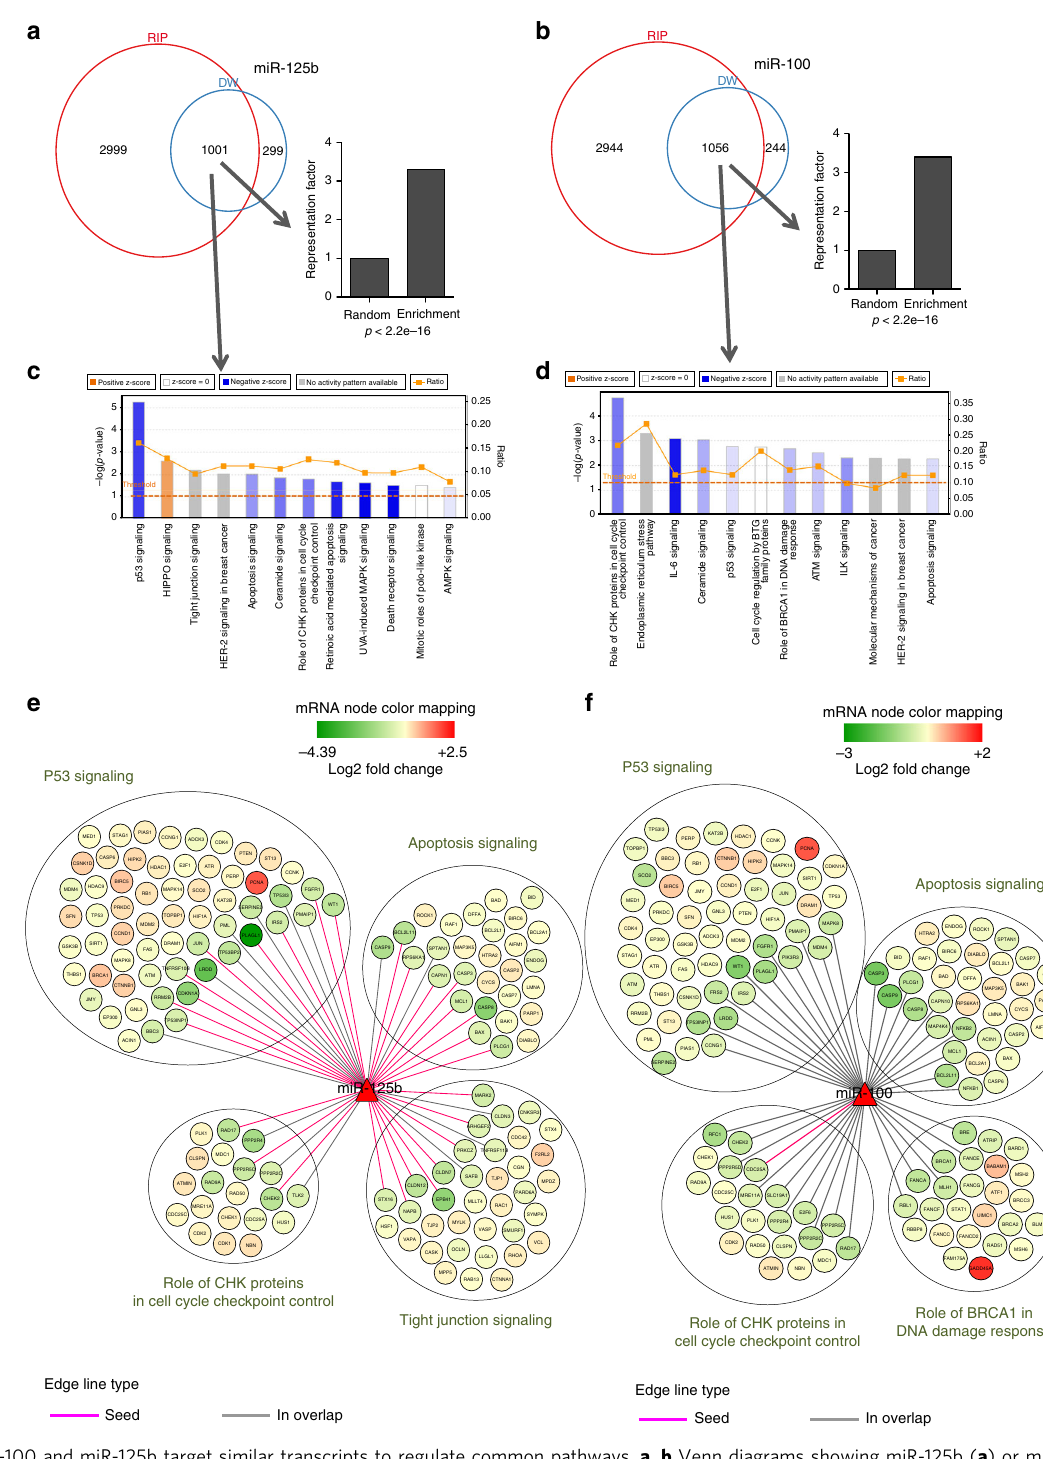
Fig. 7 miR-100 and miR-125b target similar transcripts to regulate common pathways. a , b Venn diagrams showing miR-125b ( a ) or miR-100 ( b ) direct targets represented as overlap of the top 4000 transcripts most enriched onto AGO2 from RIP-seq (RIP) and the top 1300 down-regulated transcripts in RNA-seq (DW), after miRNA overexpression. The bar charts indicate the statistical signi fi cance of the overlap between the two groups. P -values were calculated using exact hypergeometric probability test. c , d IPA shows the most enriched canonical pathways for miR-125b ( c ) or miR-100 ( d ). Genes from the overlap between RIP and DW were used as input for the analysis. The threshold of signi fi cance is indicated by the intermitted line. Positive Z-score (red) indicates that the canonical pathway is activated and negative Z-score (blue) that is inhibited, based on the expression values in the data set. e , f Sub- networks of genes belonging to signi fi cantly enriched IPA canonical pathways using the gene signature coming from overlap between RIP and DW regulated by miR-125b ( e ) or miR-100 ( f ). MiRNA – target interactions inferred from RIP-USE are depicted by different line. Node color represents change in gene expression, from the RNA-seq, mediated by the overexpression of each